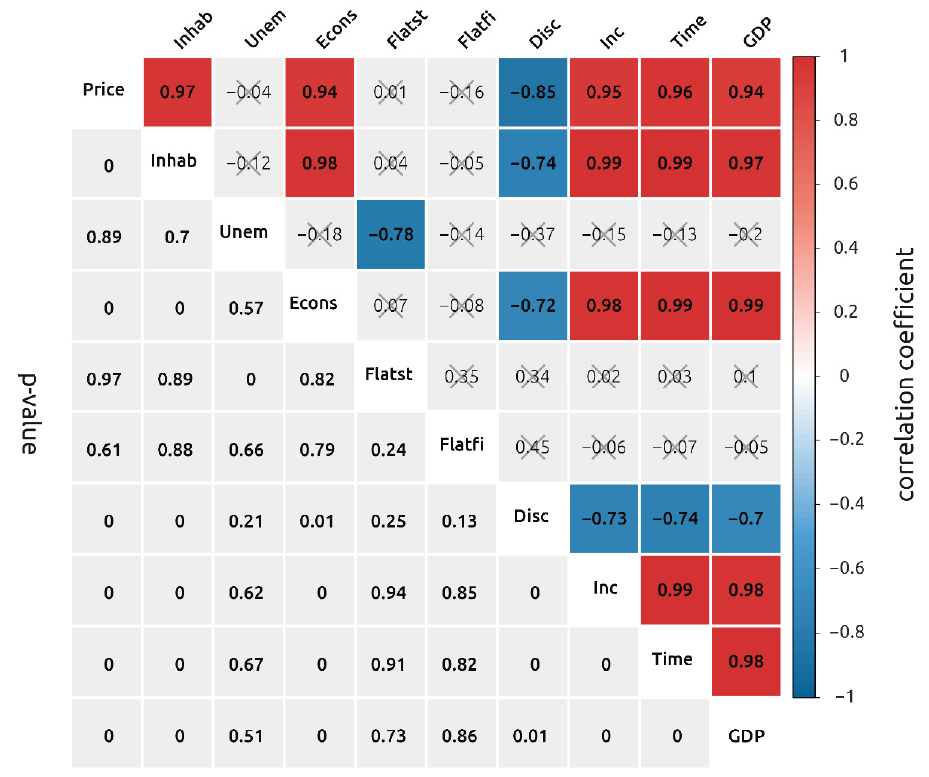
Figure 6. Correlation matrix for the city of Olomouc.